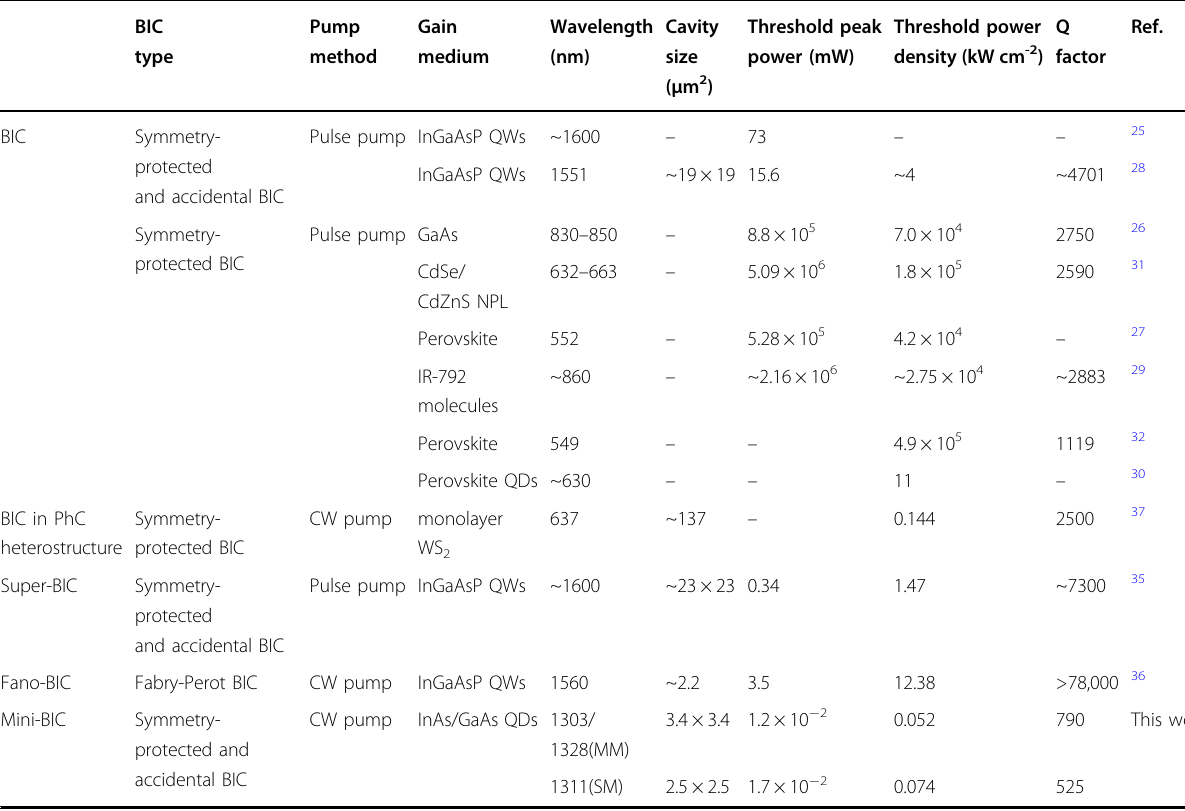
Table 1 Comparison of the mini-BIC laser with other BIC lasers